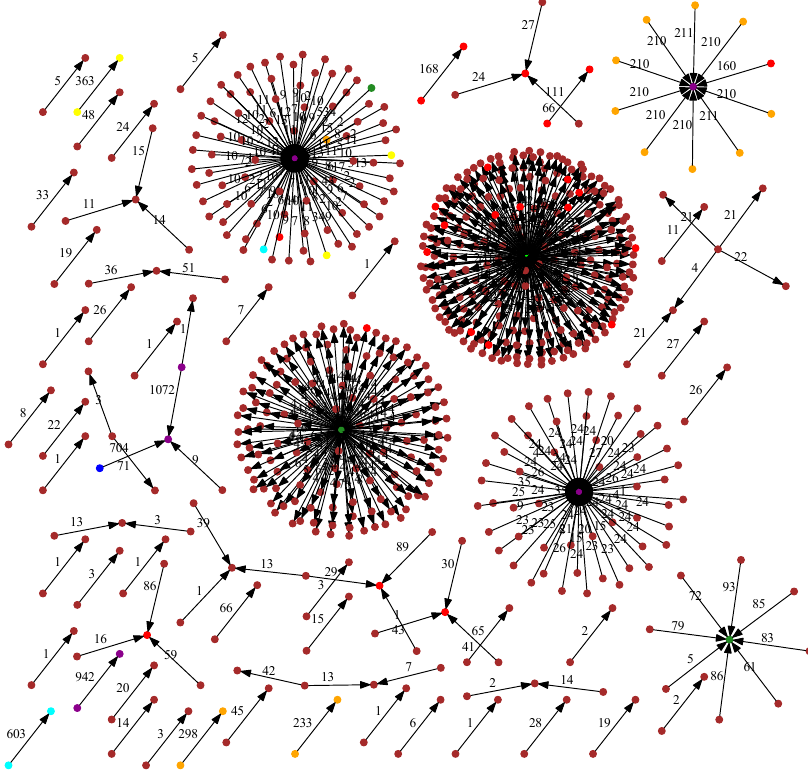
Figure 7. An illustration example of NFCG visualization, using the GraphViz tool, 500 flows of MAWI Working Group WIDE Project Traffic traces on 15 October 2018. The traffic of MAWI Working Group WIDE Project Traffic traces will be used for simulating network normal traffic. Combined with the simulated traffic dataset from the Georgia Tech Network Simulator (GTNetS), the ultimate mixed network flow dataset are validated for identifying hosts in NFCG which act as network worm victims (the cascading motif exists in the connected behavior graph of a